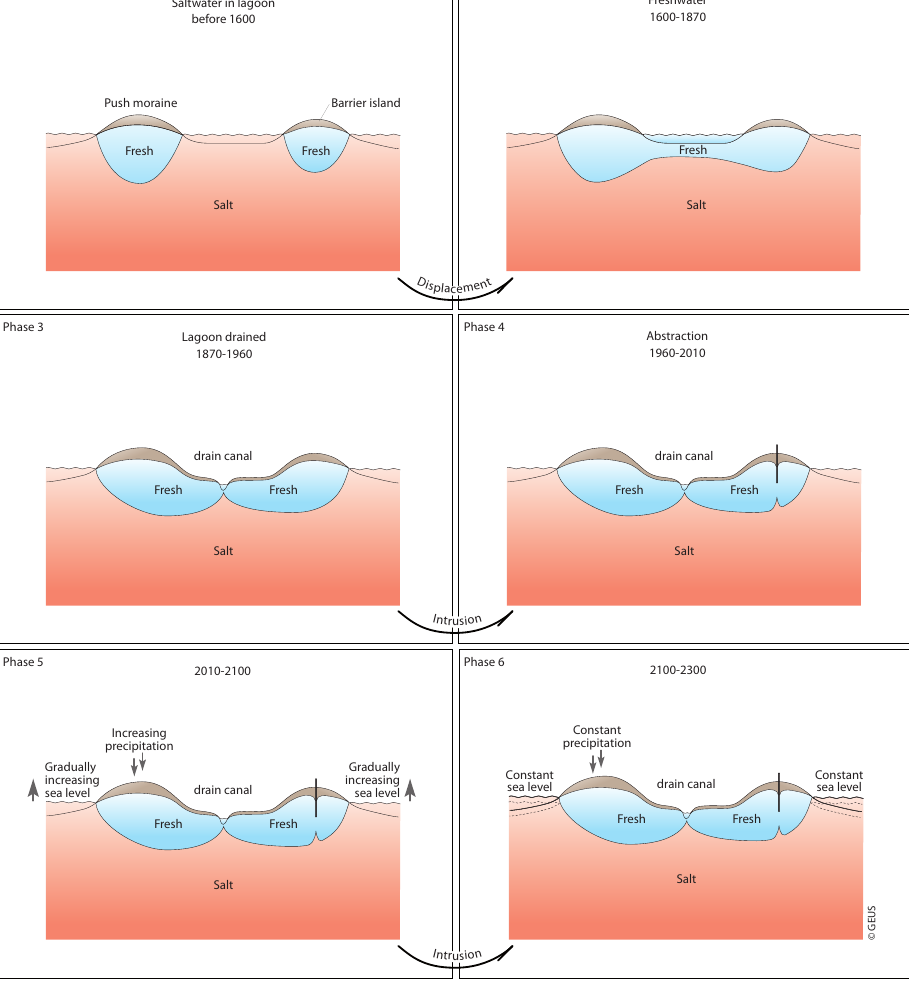
Fig. 5. Modeled transition phases of study area from lagoon with barrier islands to reclaimed land with groundwater abstraction and climate change impacts. Model results of previous phase define initial conditions of subsequent